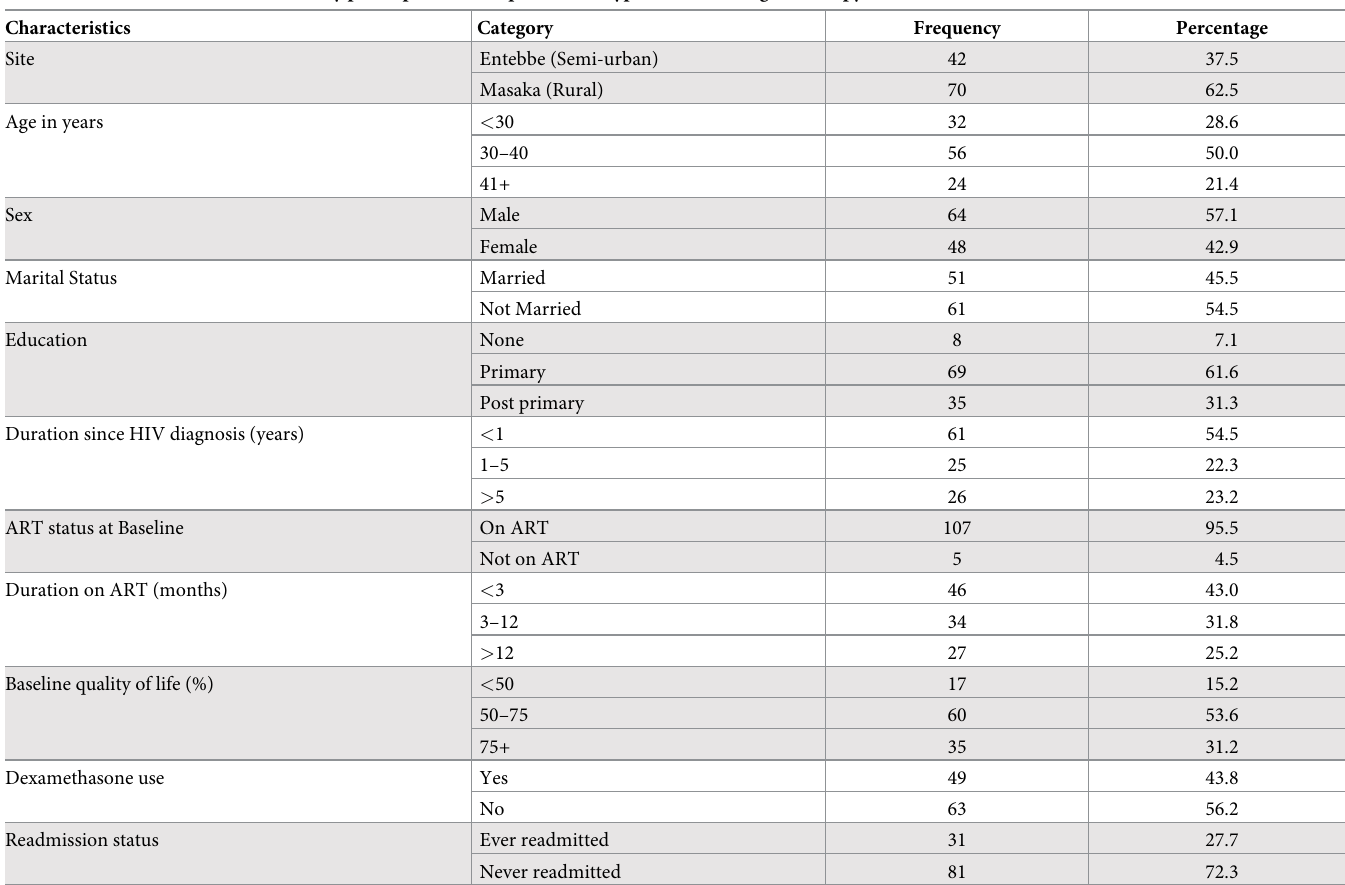
Table 1. Baseline characteristics of study participants at completion of Cryptococcal meningitis